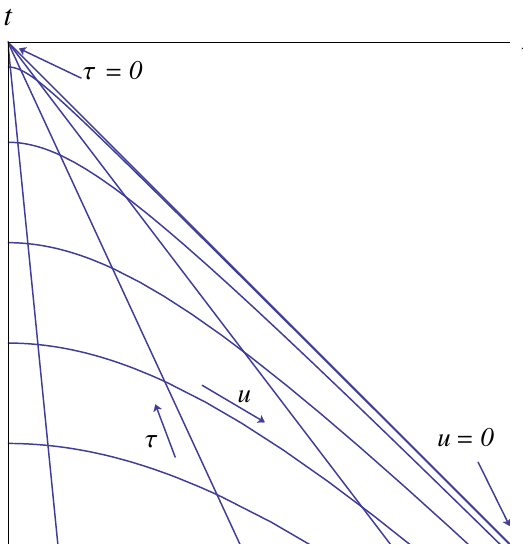
Figure 7. Relation between Poincar(cid:19)e coordinates ( t; z ) and dS-slicing coordinates ( (cid:28); u ). Constant u curves are half straight lines all ending at the origin ( (cid:28) ! 0 (cid:0) ); constant (cid:28) curves are branches of hyperbolas ending at u = 0 (null in(cid:12)nity on the z = (cid:0) t line). The boundary z = 0 corresponds to u ! (cid:0)1